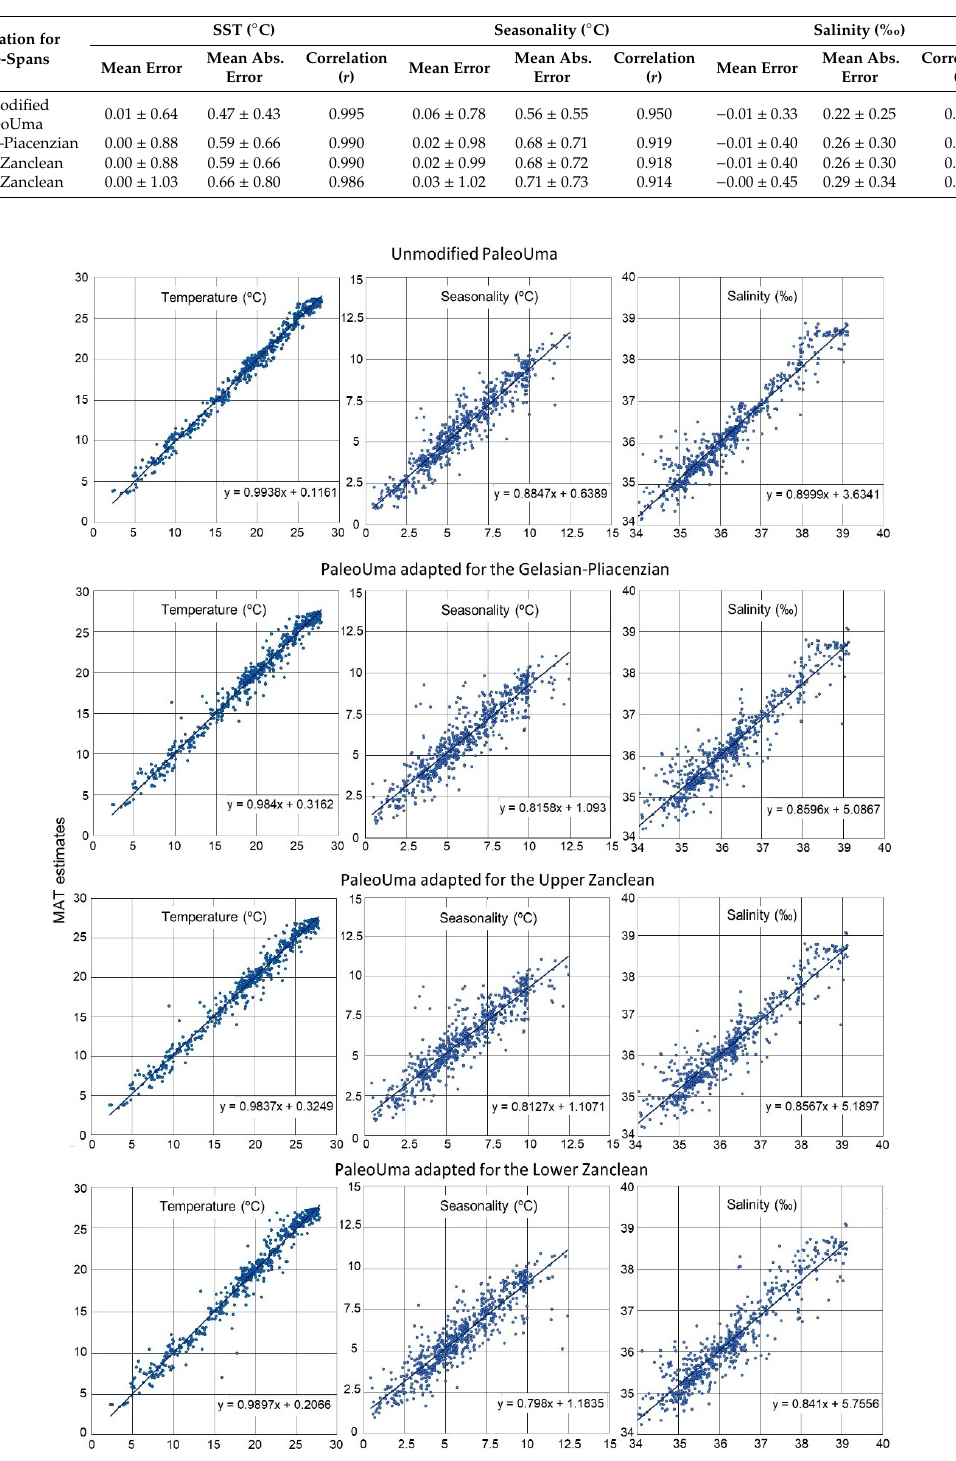
Figure 4. Analyzing the behavior of the PaleoUma calibration database by means the leave-one-out method. Comparison between the National Oceanographic Data Center (NOCD) values and modern analog technique (MAT) estimates.